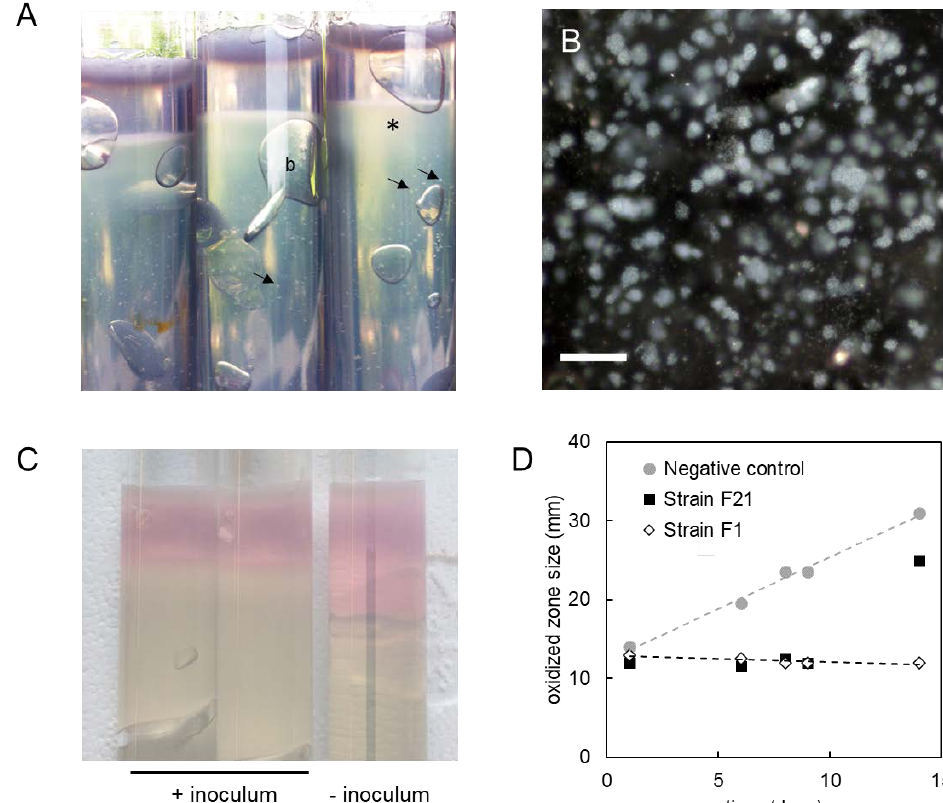
Figure 3. Growth of strains F1 T and F21 T in oxygen gradient cultures. ( A ) Cysteine-reduced cultures of strain F1 T after 19 days of incubation. Indicated are visible colonies (arrows), gas bubbles (b) and diffuse growth at the oxidized/reduced interface (*). ( B ) Micrograph showing the growth of microcolonies at the turbid oxidized/reduced interface. The scale bar represents a length of 100 µM. ( C ) Sulfide-reduced cultures after 8 days of incubation, of which two were inoculated with strain F21 T (left) and one was left uninoculated as the negative control (right). ( D ) Size of the pink oxidized zone versus incubation time in cultures reduced with sulfide. The negative controls were uninoculated. Plotted values are averages of two replicate cultures, which behaved reproducibly.